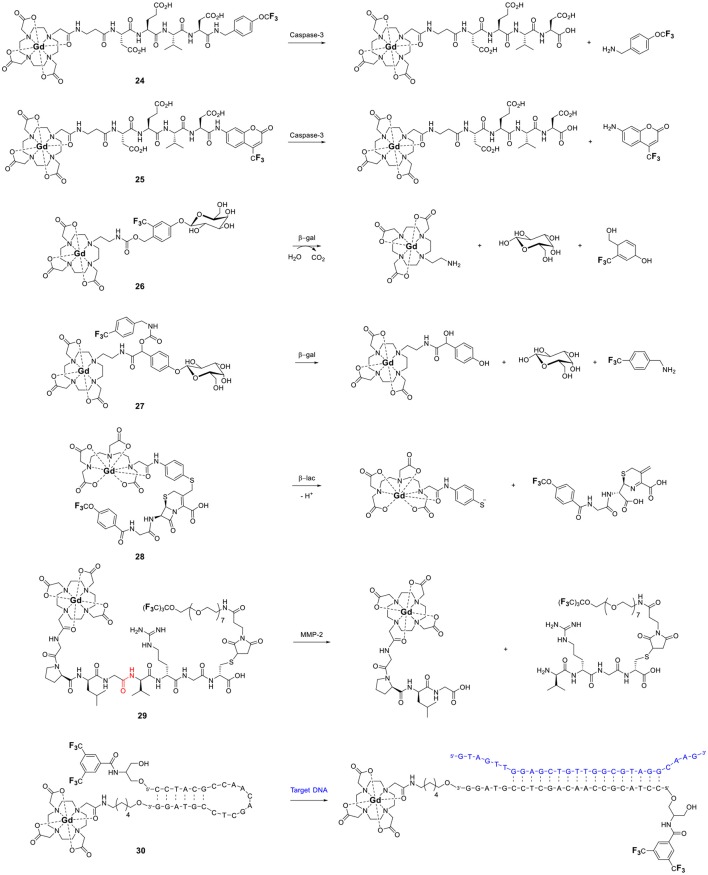
Responsive fluorinated probes whose signals are modulated by the paramagnetic relaxation enhancement effect of GdIII (24, Mizukami et al., 2008; 25, Mizukami et al., 2009; 26, Mizukami et al., 2011; 27, Keliris et al., 2012; 28, Matsushita et al., 2012; 29, Yue et al., 2014, 2017; 30, Sakamoto et al., 2011).